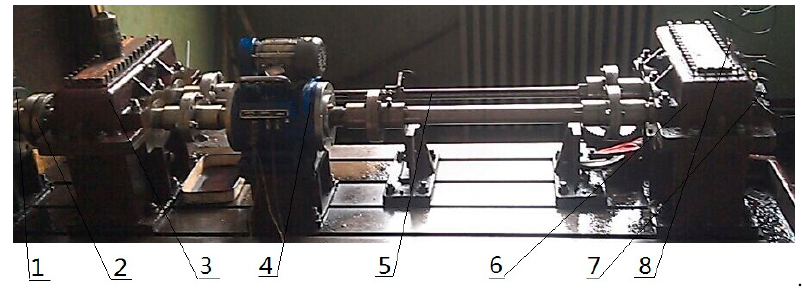
Figure 12. Gearbox test rig.